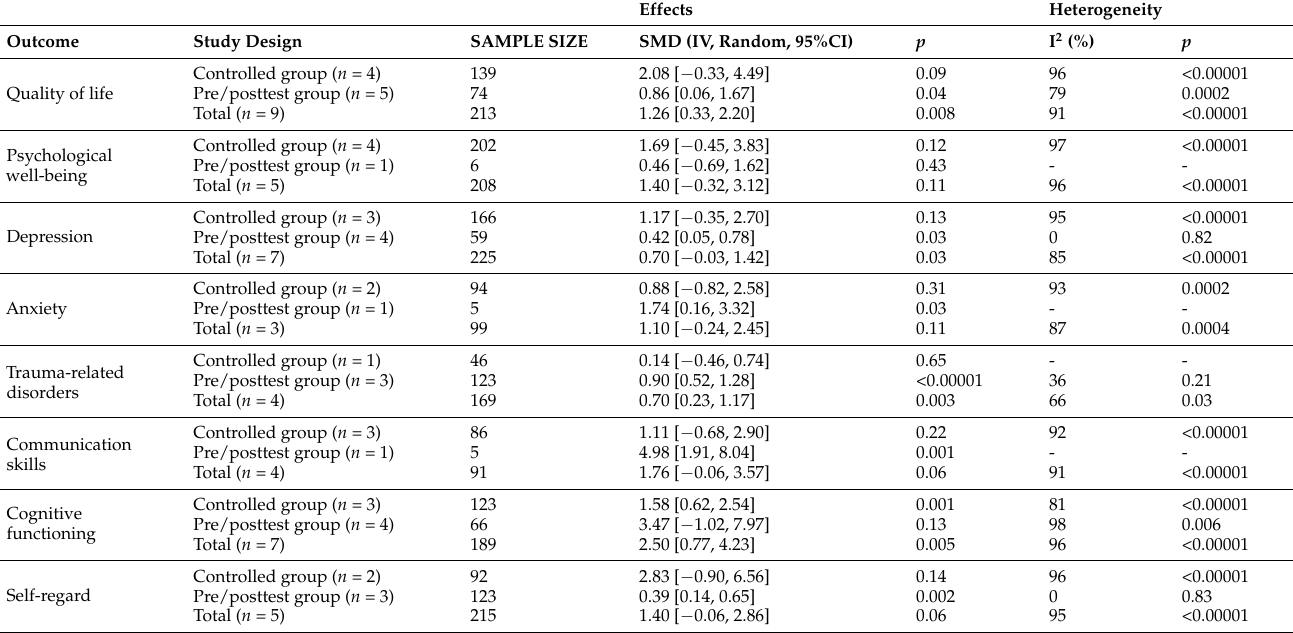
Table 3. Effects and heterogeneity for comparisons between